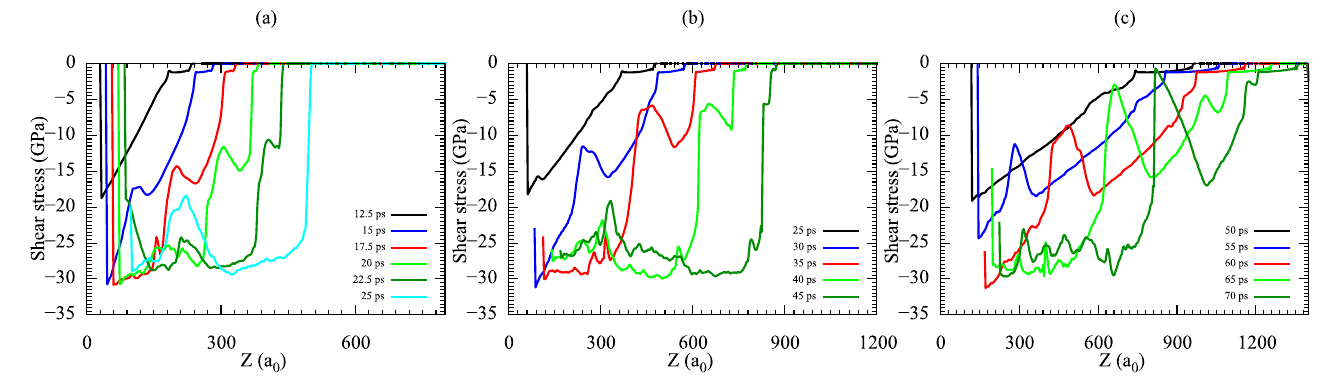
Figure 3. Shear stress profiles along the loading direction Z for ramp rise times of 15 ps ( a ), 30 ps ( b ), and 60 ps ( c ).